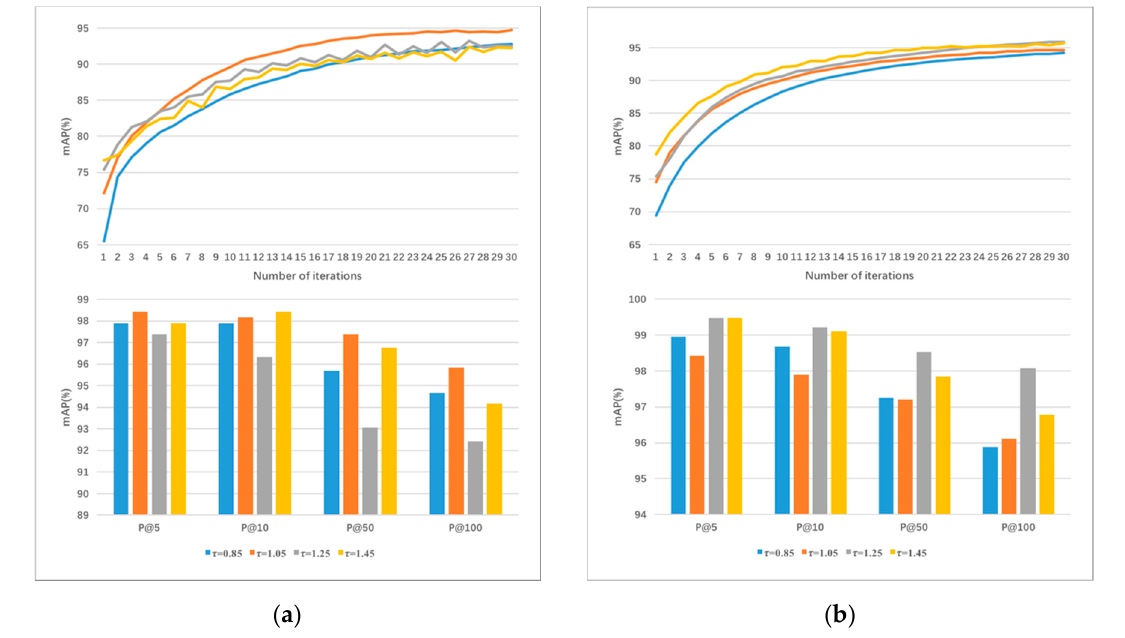
Figure 7. The impact of the different threshold τ . Evaluation is performed with VGG16 ( a ) and ResNet50 ( b ) on PatternNet datasets. The curve represents the evolution of mAP in the training iteration. The histogram shows the evaluation of P@K under different thresholds τ .